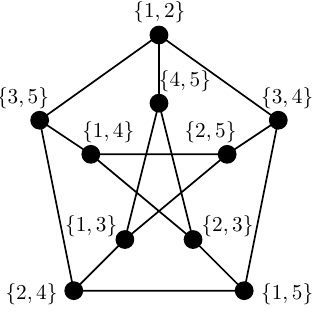
Figure 1. The Petersen